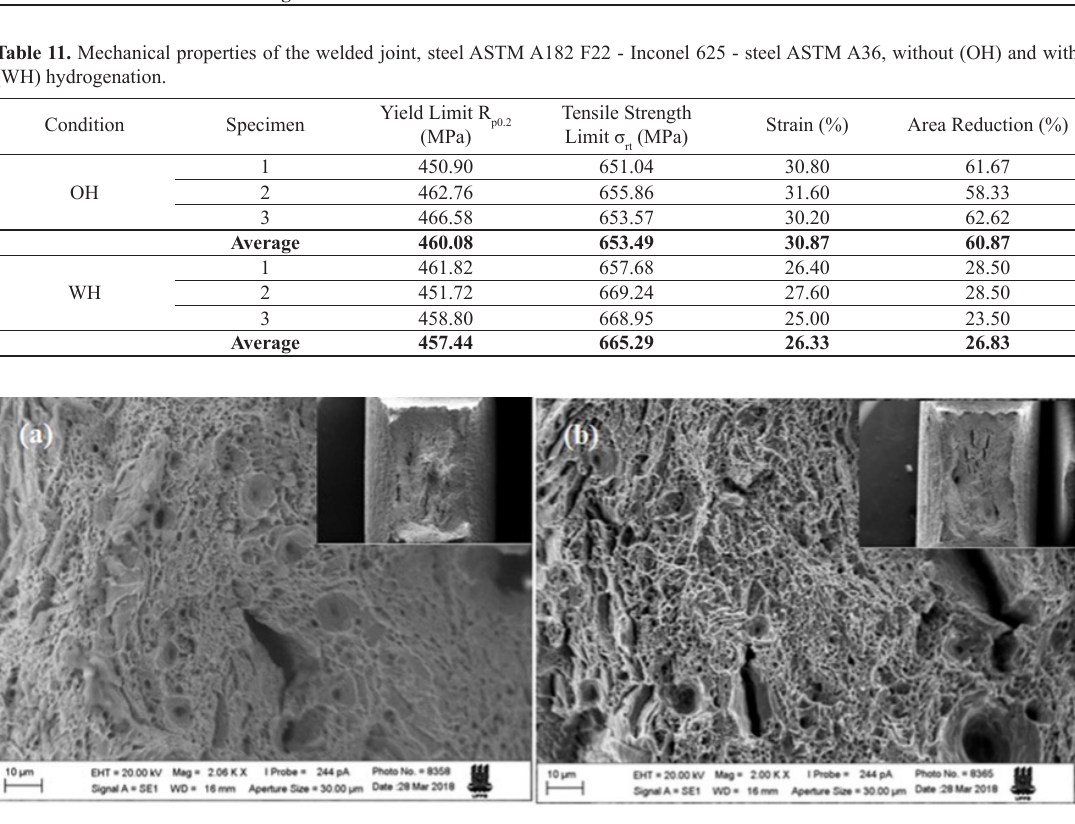
Figure 14. Fractography of the tensile test of forged ASTM A182 F22 steel, extracted from the joint. (a) without. (b) with hydrogenation.